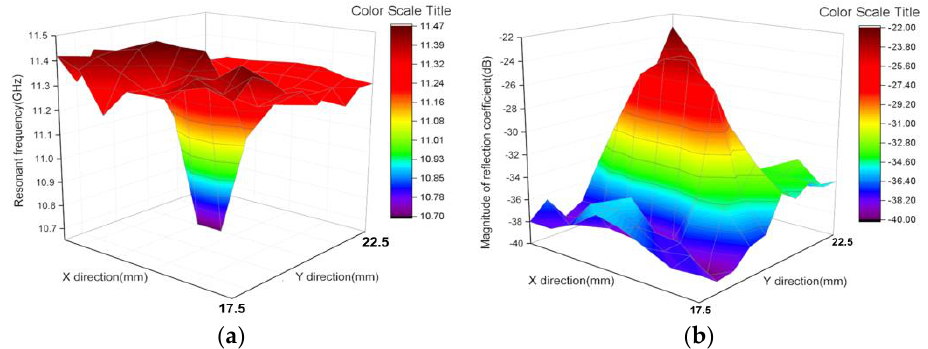
Figure 16. The measurement results of two-dimensional direction for abnormal tissue detection: ( a ) Images using resonant frequency; ( b ) Images using magnitude of reflection coefficient.